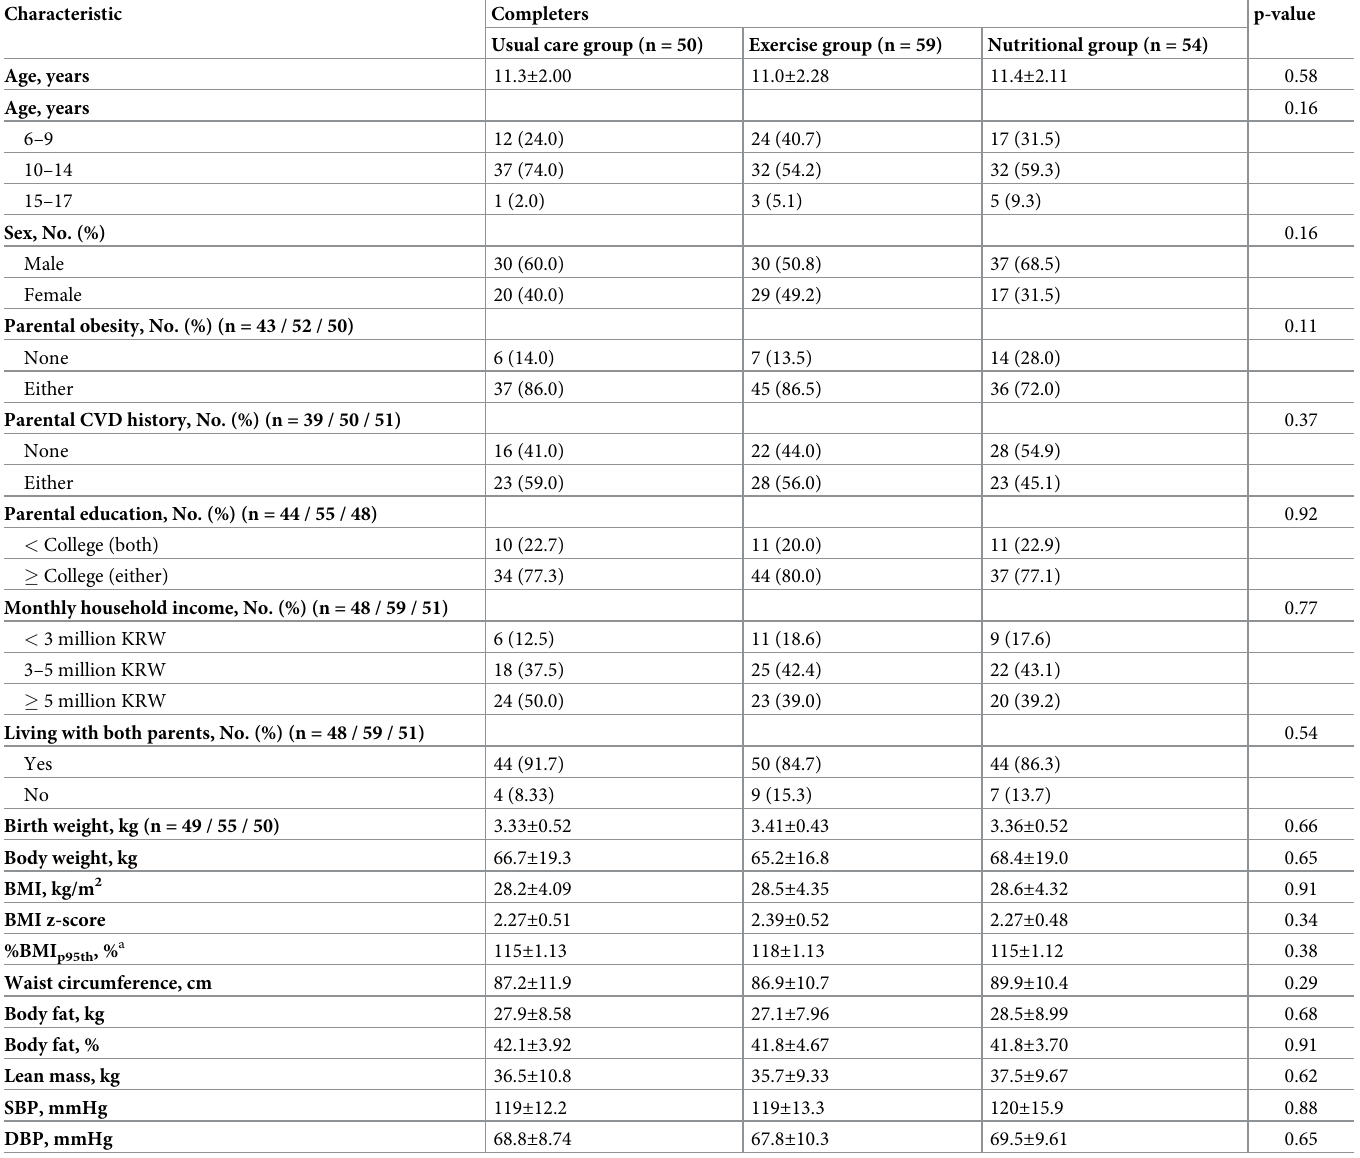
Table 1. Baseline demographic characteristics and anthropometric measurements of